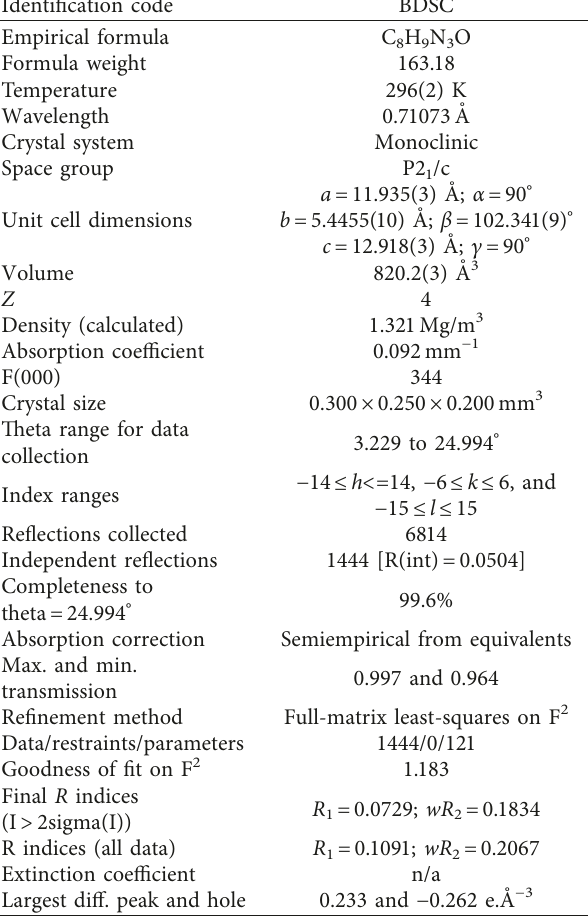
Table 2: Experiment and theoretical binding energies of BDSC crystals are